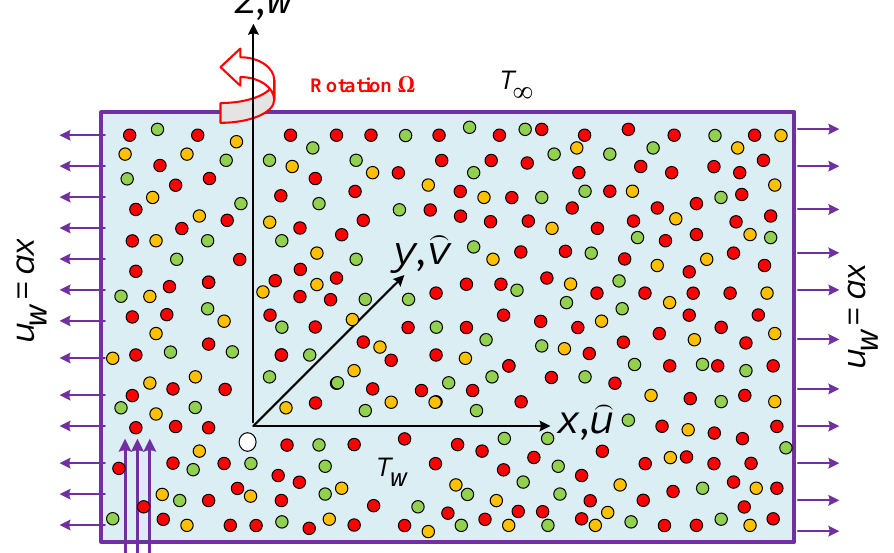
Figure 1. Schematic flow